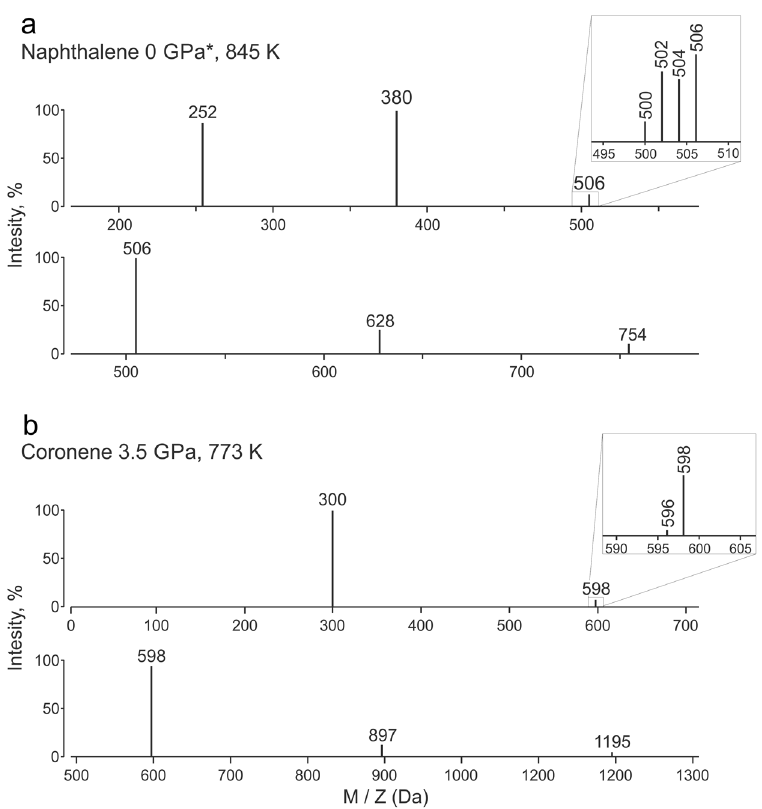
Figure 3. MALDI mass spectra of PAH experimental products. ( a ) – naphthalene at 1 bar and 845 K. ( b ) – coronene at 3.5 GPa and 773 K. * 0 GPa = 1